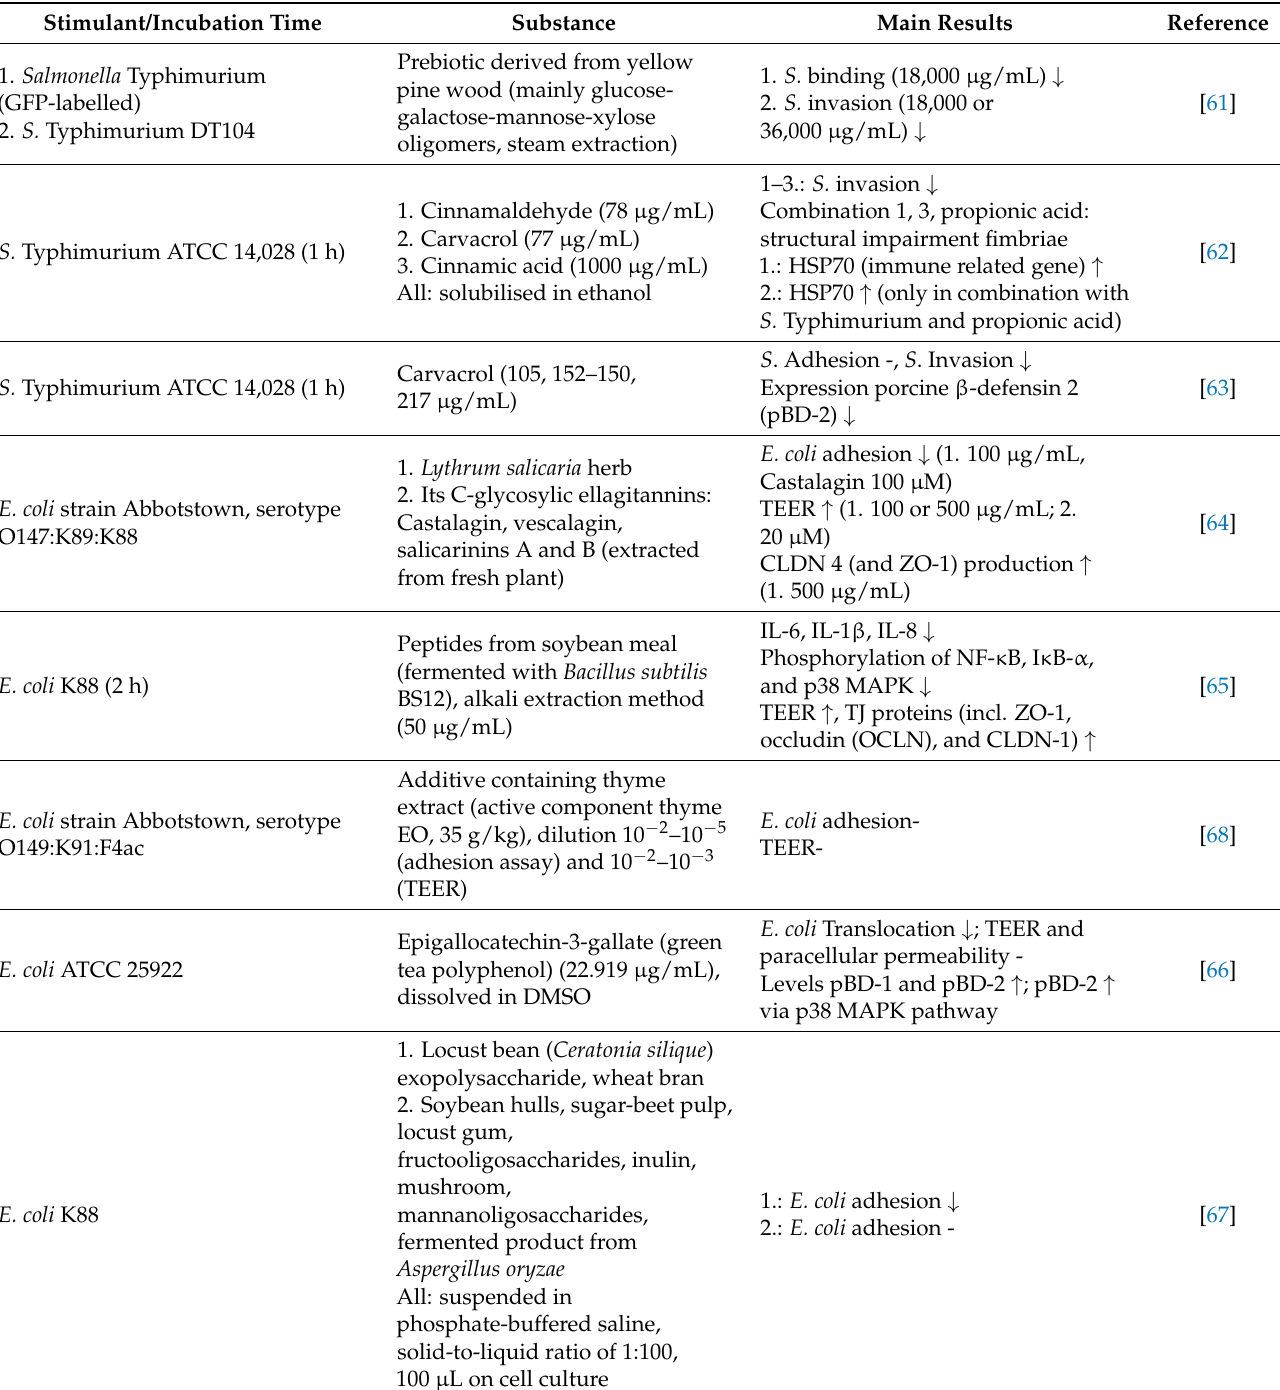
Table 2. Effects of PFA on infection of IPEC-J2 cells with intestinal microbial pathogens. Stimulant/Incubation Time Substance Main Results